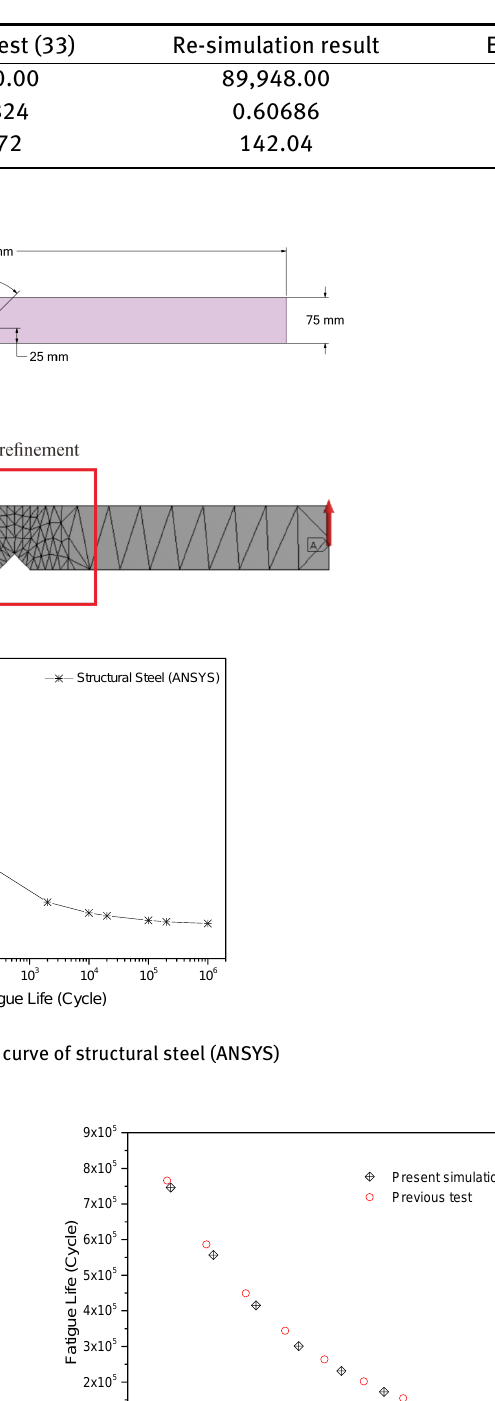
Table 4: Verification results